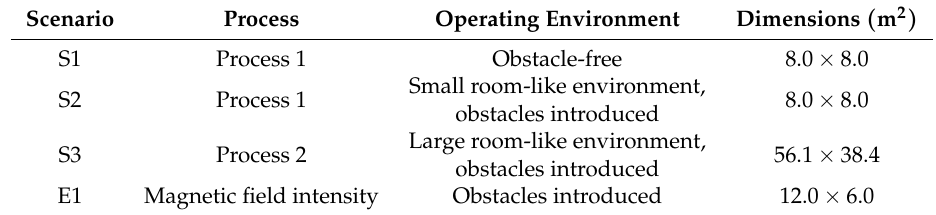
Table 1. Evaluated scenarios in simulation (Sx) and Experimental (Ex) test cases.